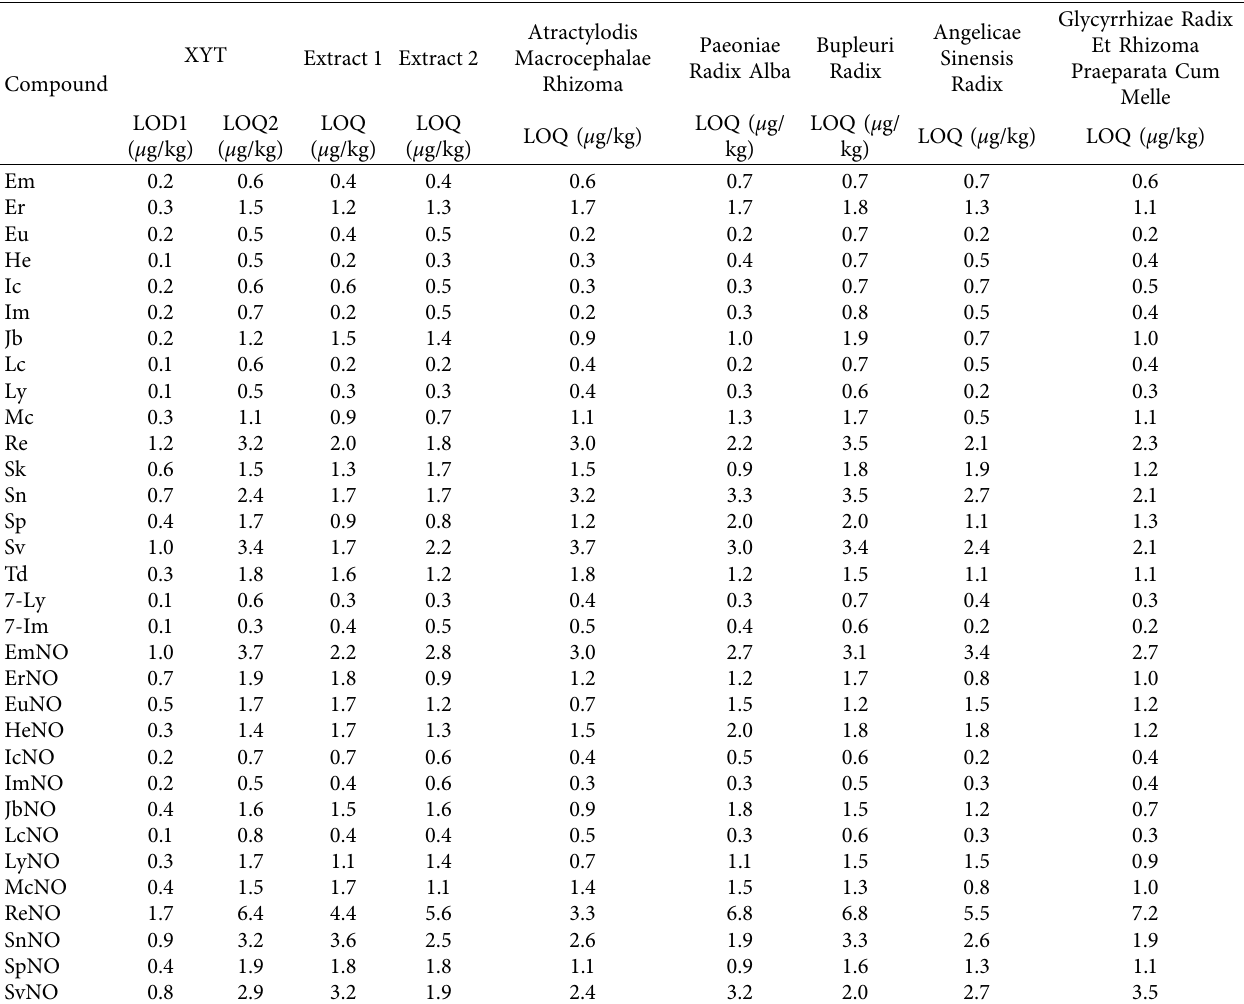
Table 3: LODs and LOQs of PAs in various